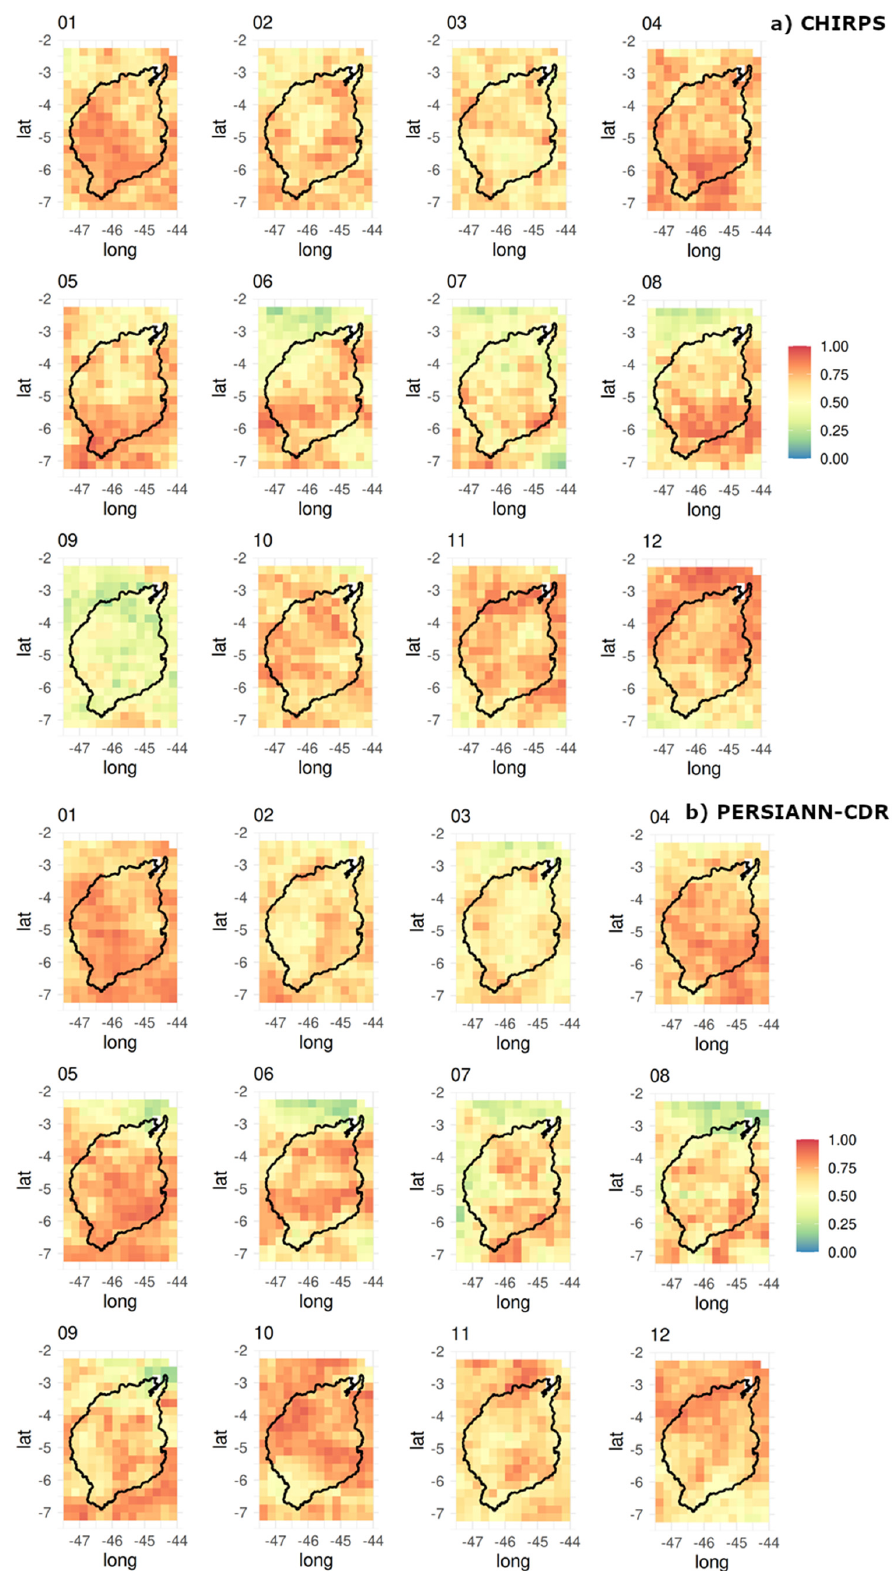
Figure 13. d (without units) monthly rx1day (gridBR × CHIRPS ( a ) and gridBR × PERSIANN-CDR ( b )) from January (01) to December (12) 1983 to 2013.